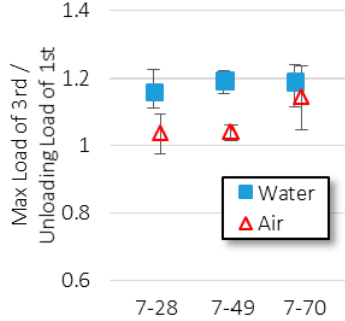
Figure 9. Ratios between the maximum load in the case of 3rd loading and unloading load in case of 1st loading (different healing periods).